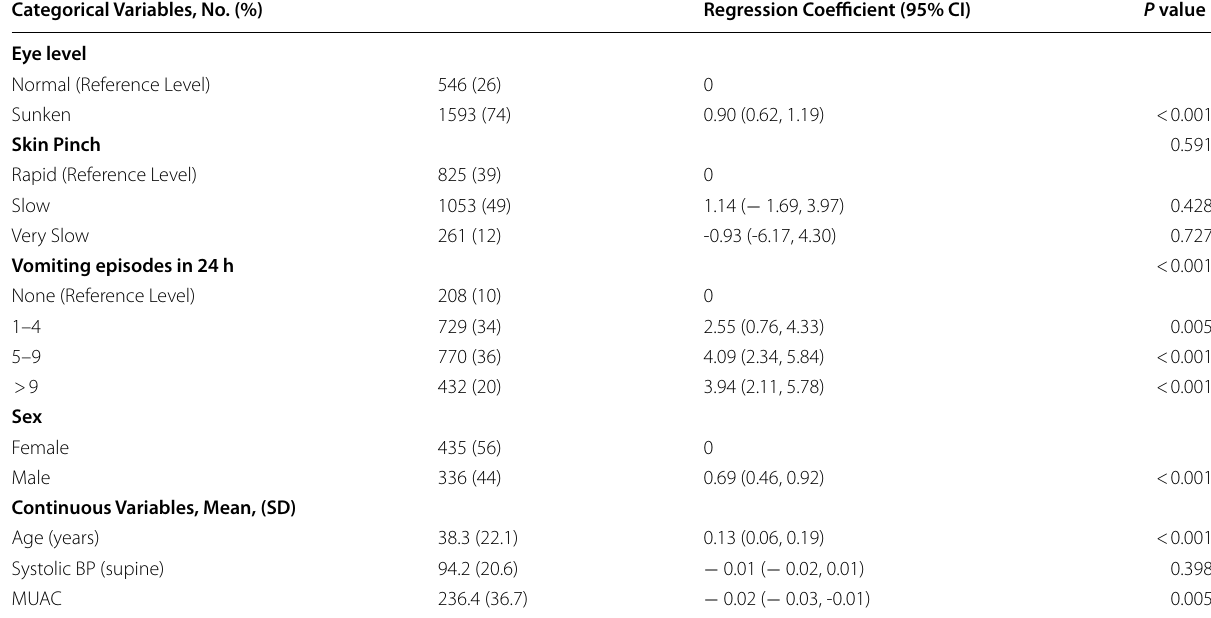
Table 4 Predictors and regression coefficients in the NIRUDAK model Categorical Variables, No.